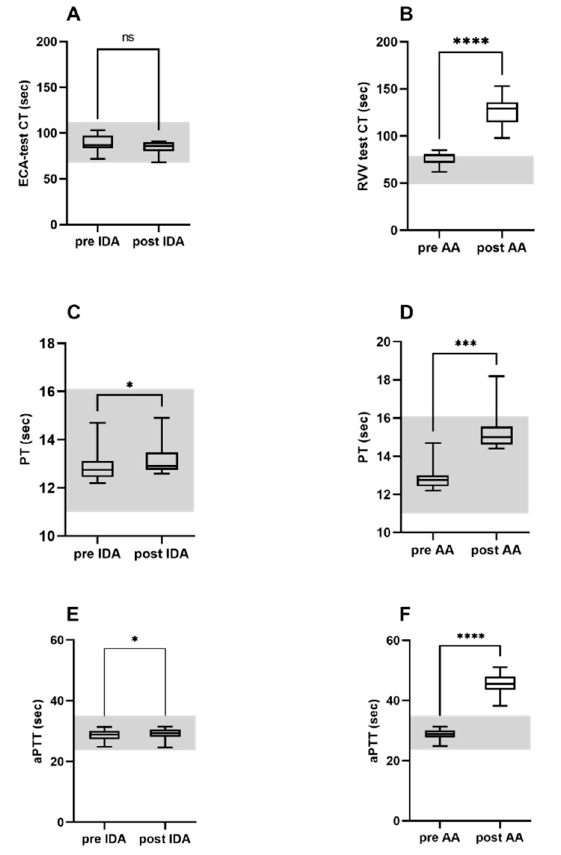
Figure 4. ( A , B ) ClotPro ® specific tests and ( C – F ) standard coagulation tests in healthy volunteers not on the antithrombotic therapy before and after spiking with Idarucizumab ( A , C , E ) and Andexanet alfa ( B , D , F ). AA: Andexanet alfa; IDA: Idarucizumab; RVV-test: Russell’s viper venom assay; ECA-test: Ecarin based assay; CT: Clotting time; PT: Prothrombin time; aPTT: Activated partial thromboplastin time; gray area represents normal limits of the specific test. * p < 0.05, *** p < 0.001, **** p < 0.0001, ns: Not significant; paired t